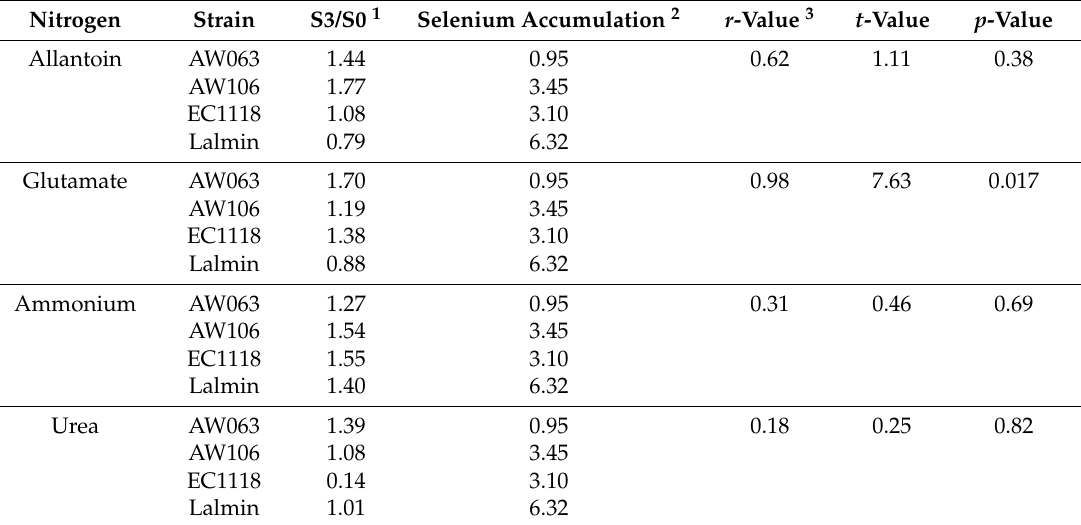
Table 3. Selenite resistance dependence on nitrogen source.